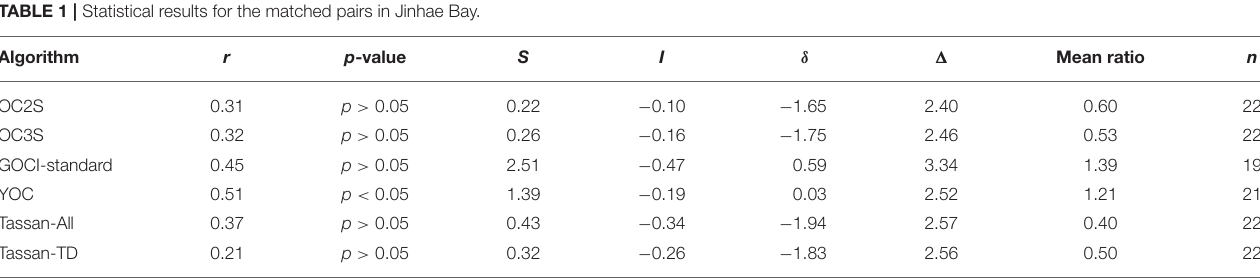
TABLE 1 | Statistical results for the matched pairs in Jinhae Bay. Algorithm